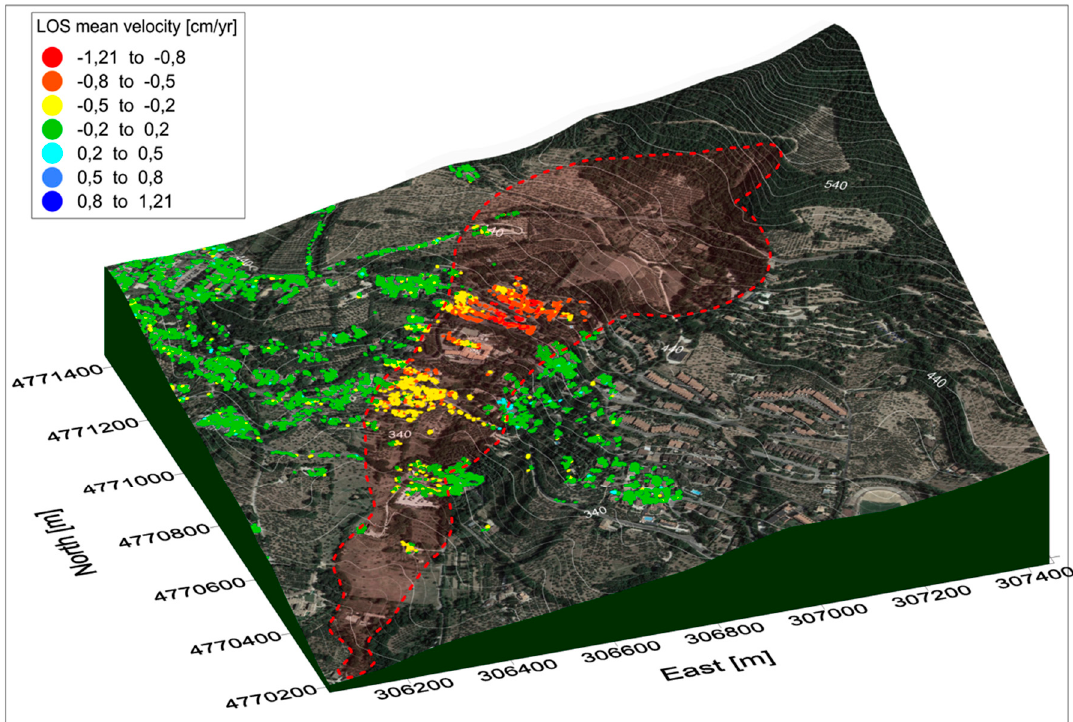
Figure 3. DInSAR measurements. CSK LOS mean deformation velocity map superimposed on the 3D view of satellite optical image with the DEM contour lines (grey lines). The red shade shows the zone involved by the recent instability phenomenon.